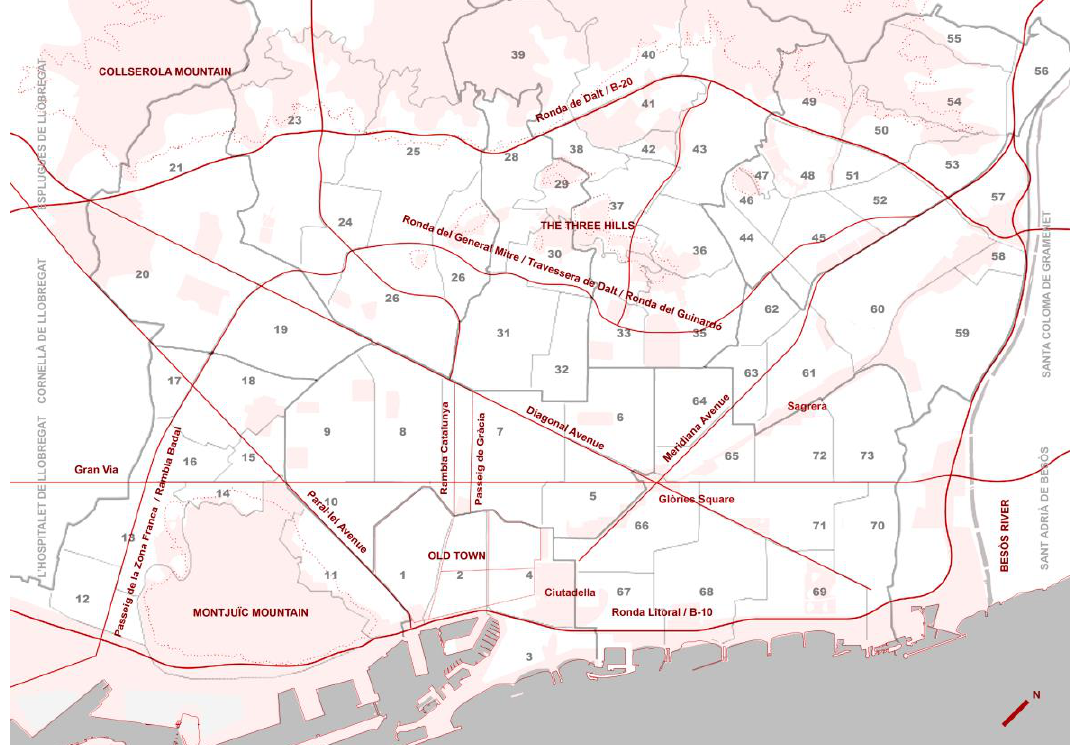
Figure 2. Map guide of the toponymy of Barcelona. Geography and main avenues are highlighted and named in red; the 73 neighborhoods composing the 10 districts are numbered as follows: in